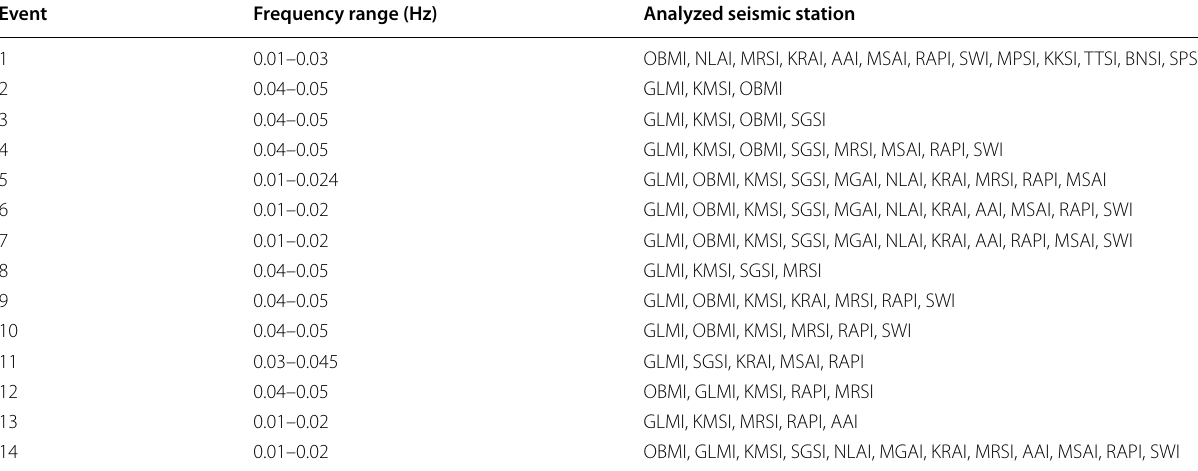
Table 2 Frequency ranges used for the analyses in this study Event Frequency range